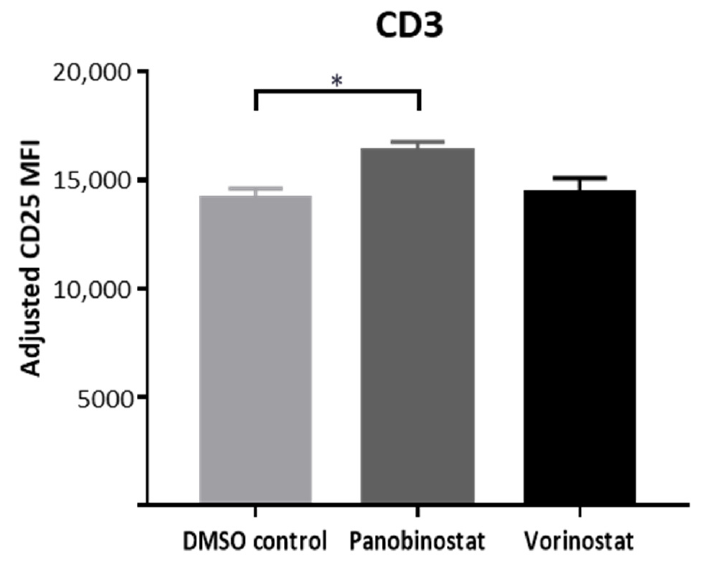
Figure 5. CD25 expression on NY-ESO-1-specific T cells after co-culture with panobinostat or vorinostat pretreated SW982 cells. DMSO served as solvent control. Data analyzed contain three individual experiments. Each experiment was performed in duplicates. Statistical significance was calculated using one-way ANOVA. * p < 0.05.